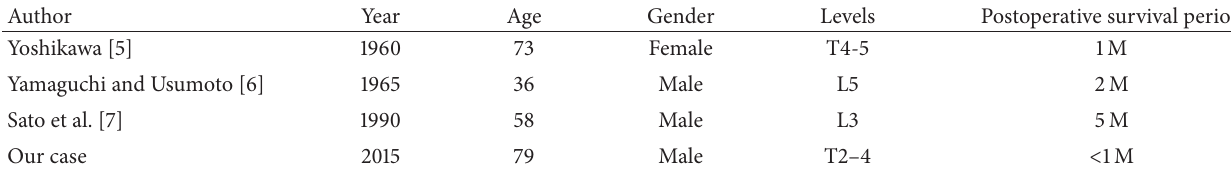
Table 1: Prior case report of solitary spinal epidural metastasis from gastric cancer in